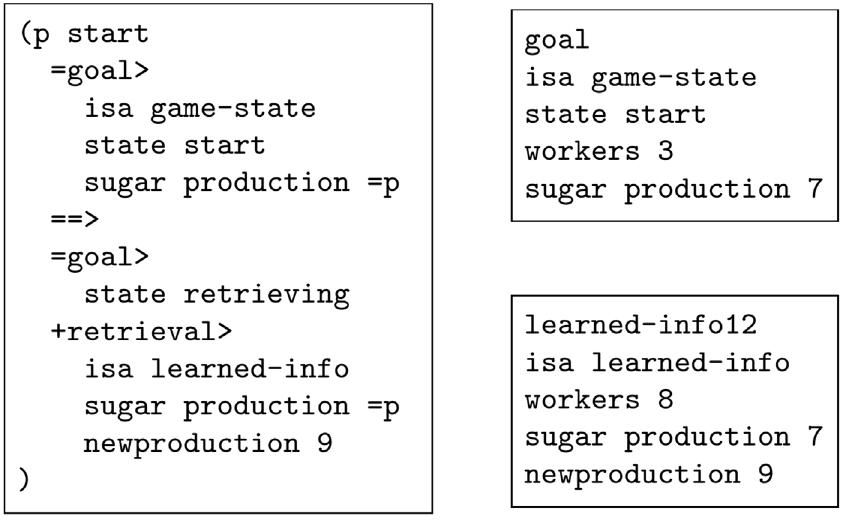
Fig 2. Examples of an ACT-R production rule (left) and of ACT-R chunks stored in declarative memory (right).